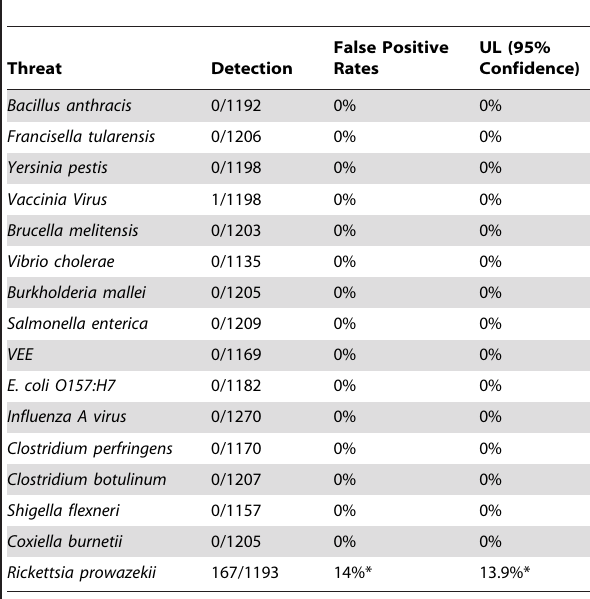
Table 4. Specificity of the biothreat assay measured as false positive